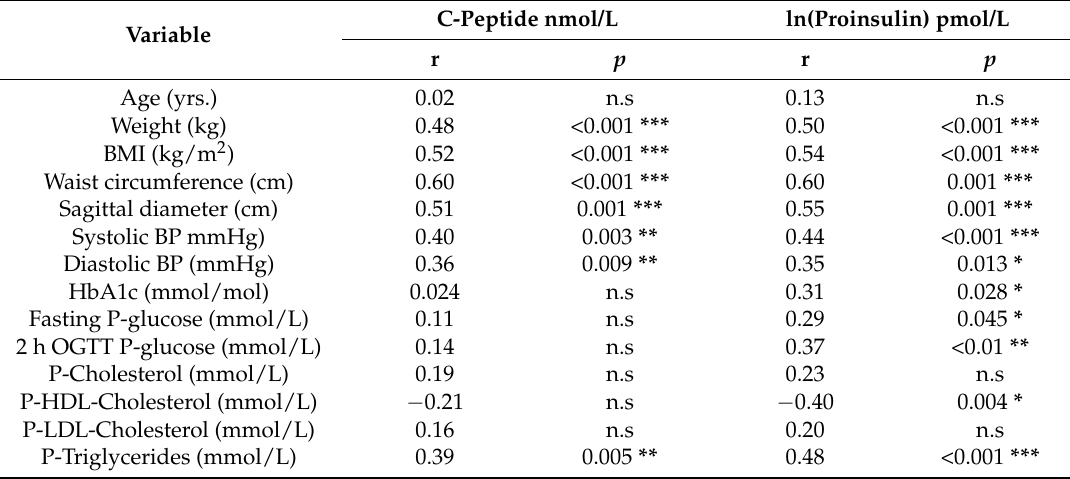
Table 3. Data shown for 51 subjects at follow-up 12 years after diagnosed gestational diabetes mellitus. Pearson correlation analyses (r) were performed between demographic/metabolic variables and ln(proinsulin) and C-peptide. Proinsulin was transformed to its corresponding natural logarithm (ln) to accomplish a normal distribution. Plasma glucose was measured using the capillary